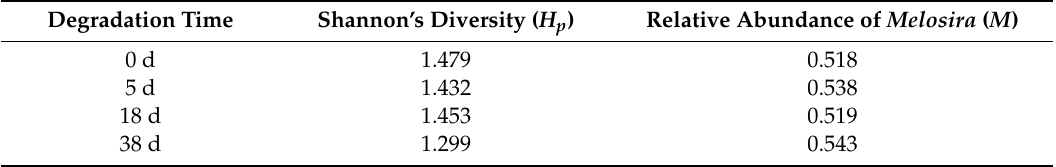
Figure 2. Variations of phytoplankton cell abundance (genera). Table 3. Relative abundance of Melosira ( M ) and Shannon’s diversity ( H p ) of phytoplankton. Degradation Time Shannon’s Diversity ( H p